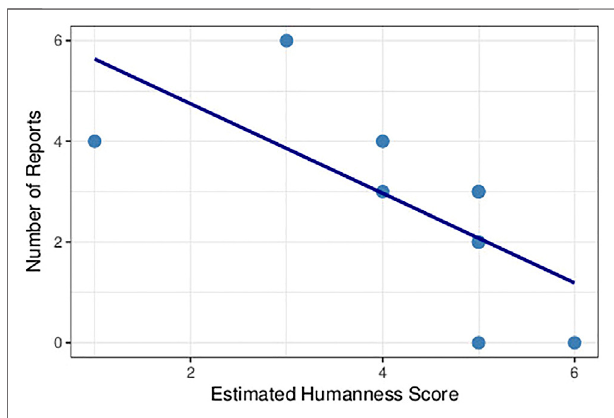
FIGURE 10 | Negative correlation between the bots ’ estimated humanness and the number of reports in the control